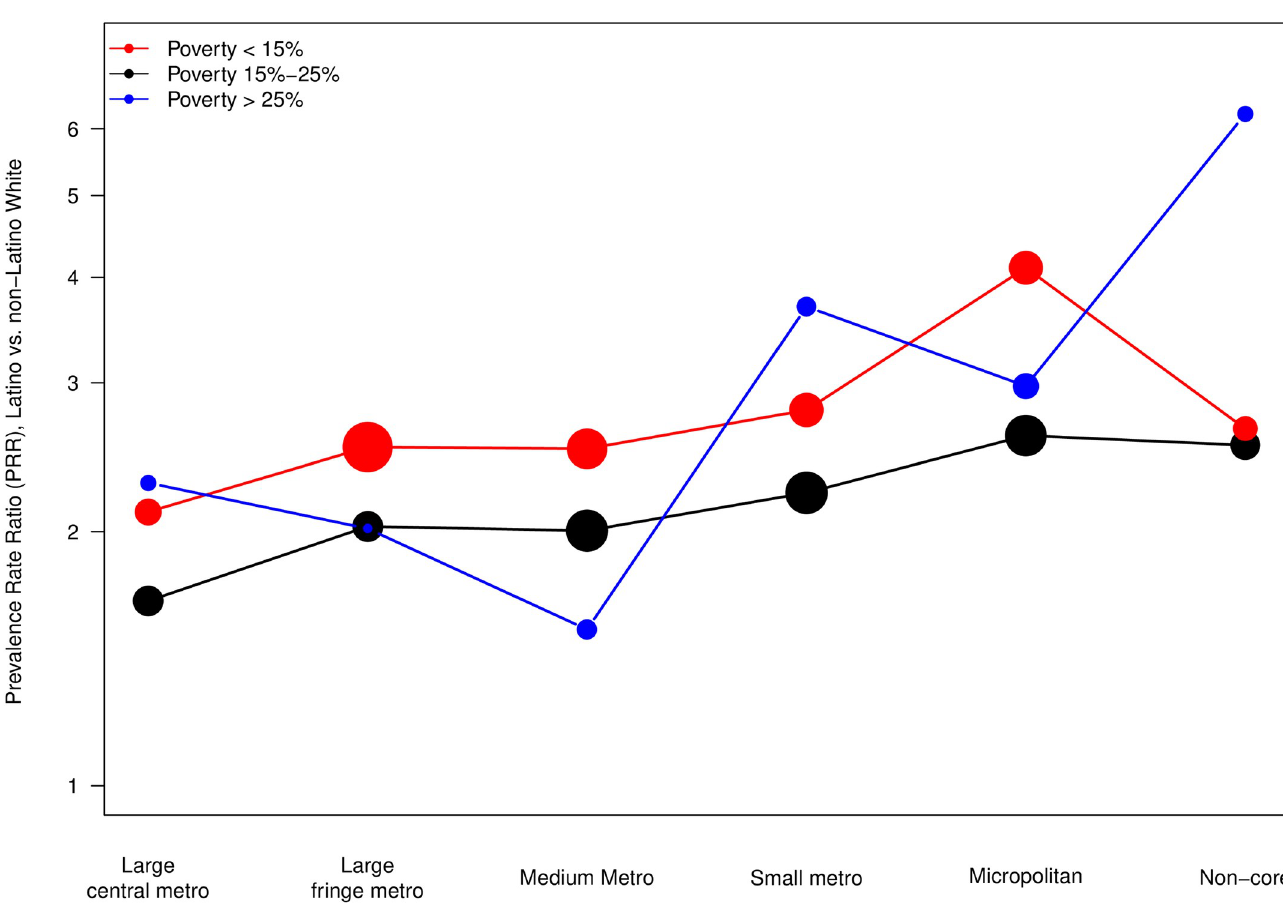
Fig 3. Median Latino and Non − Latino white diagnosed HIV prevalence rate ratio by urbanicity within levels of percent in poverty within county (N = 775 counties). The size of circle is proportional to number of counties within urbanicity and poverty